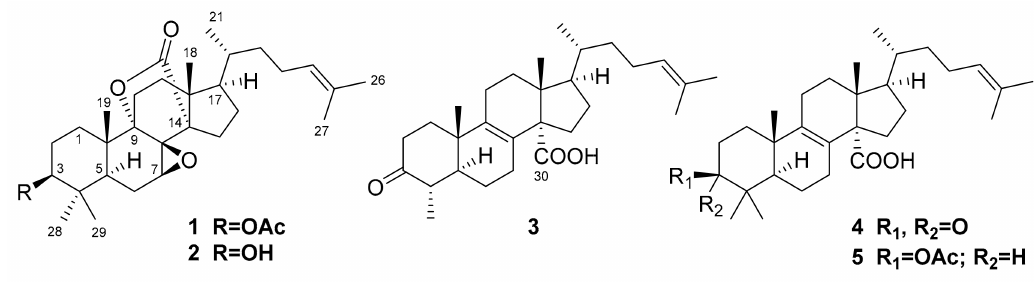
Figure1. Thestructuresofinvestigatedcompounds: 3 β -acetoxy-7 β ,8 β -epoxy-5 α -lanost-24-en-30,9 α -olide( 1 ), 3 β -hydroxy-7 β ,8 β -epoxy-5 α -lanost-24-en-30,9 α -olide ( 2 ), 29- nor -penasterone ( 3 ), penasterone ( 4 ), and acetylpenasterol ( 5 ).